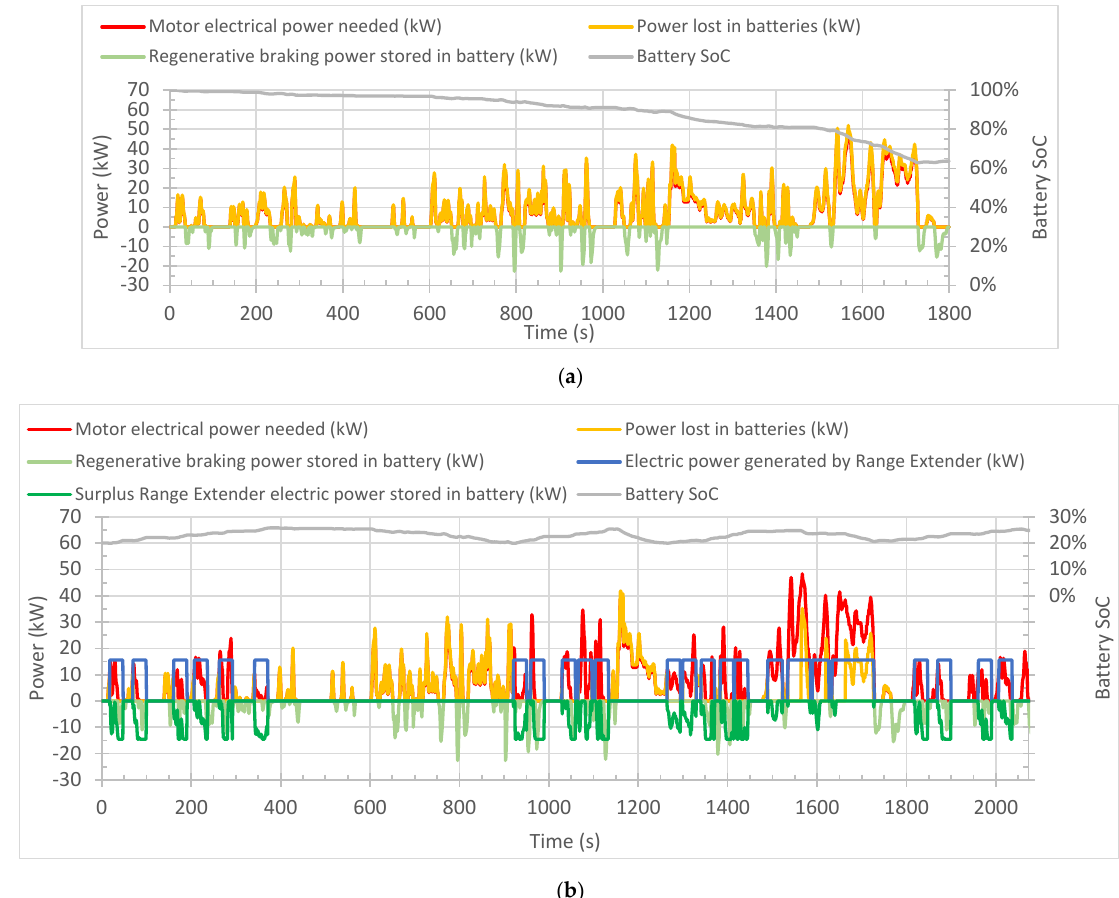
Figure 7. Power parameters and state-of-charge for ( a ) charge depleting starting from full charge, under a single WLTC cycle and ( b ) charge sustaining starting from 20% state of charge (SoC) under an extended WLTC cycle (25 km).